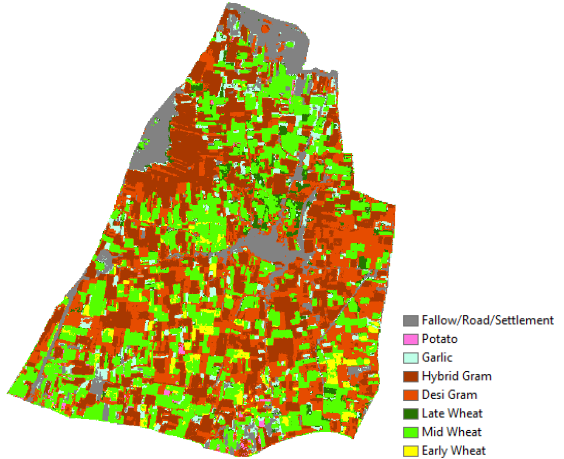
Figure 7: Classified Image of the study area as of 31 December 2017 using multi temporal satellite data and RF